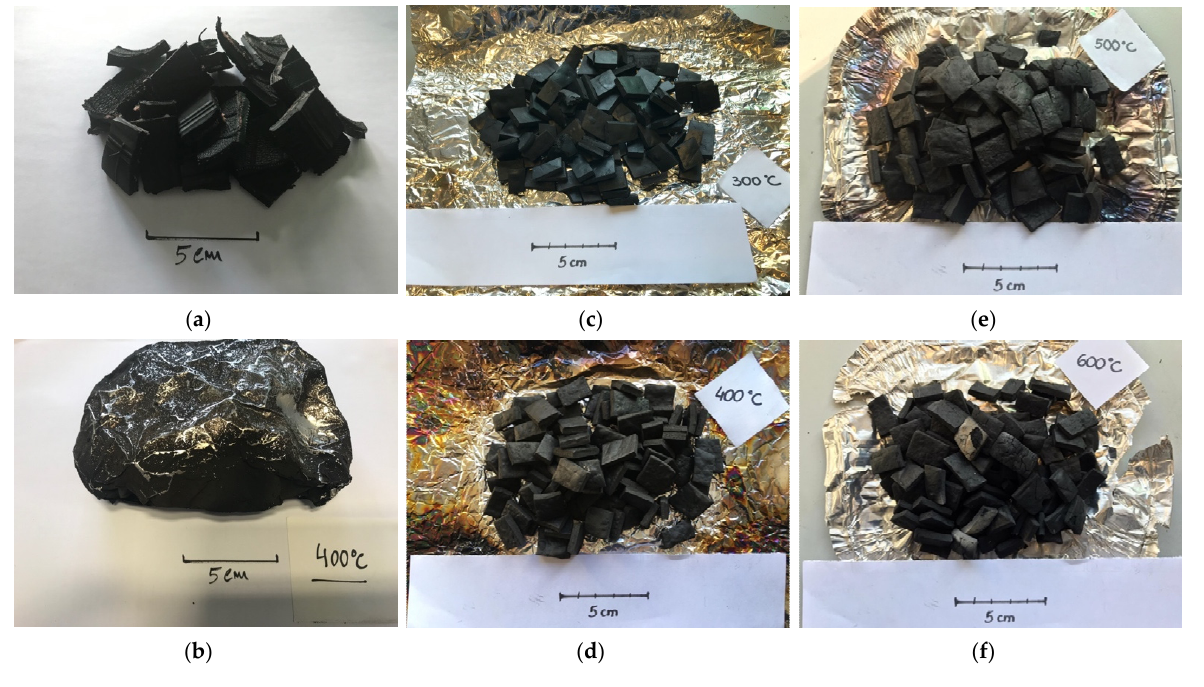
Figure 1. Results of the laboratory procedures for producing carbonized rubber samples—RC. ( a ) Sample of non-heat-treated tire rubber; ( b ) Sample wrapped in the aluminum foil according to the procedure described in Nunes et al. at a temperature of 400 °C [46]; ( c ) Carbonized material at a temperature of 300 °C; ( d ) Carbonized material at a temperature of 400 °C; ( e ) Carbonized material at a temperature of 500 °C; and ( f ) Carbonized material at a temperature of 600 °C.